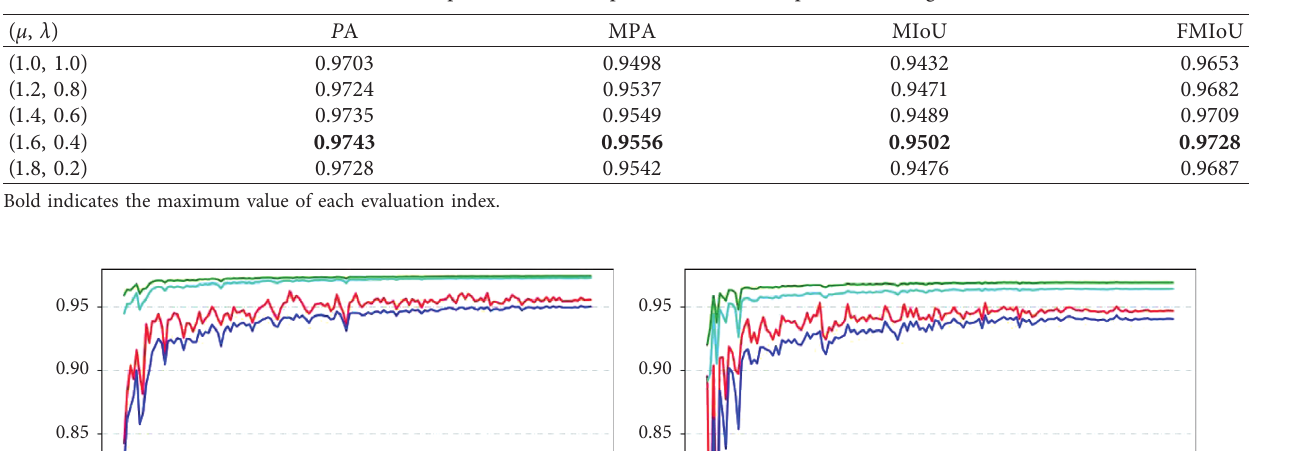
Table 3: The net performance comparison of different parameter weights.